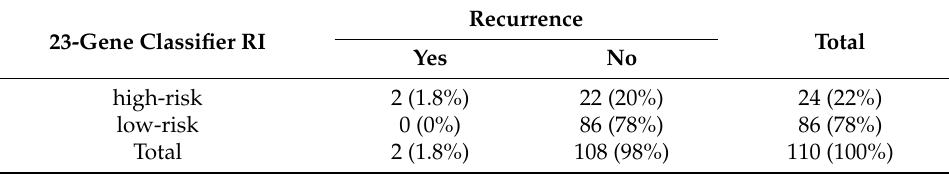
Table 4. Clinical performance of the 23-gene classifier RI.